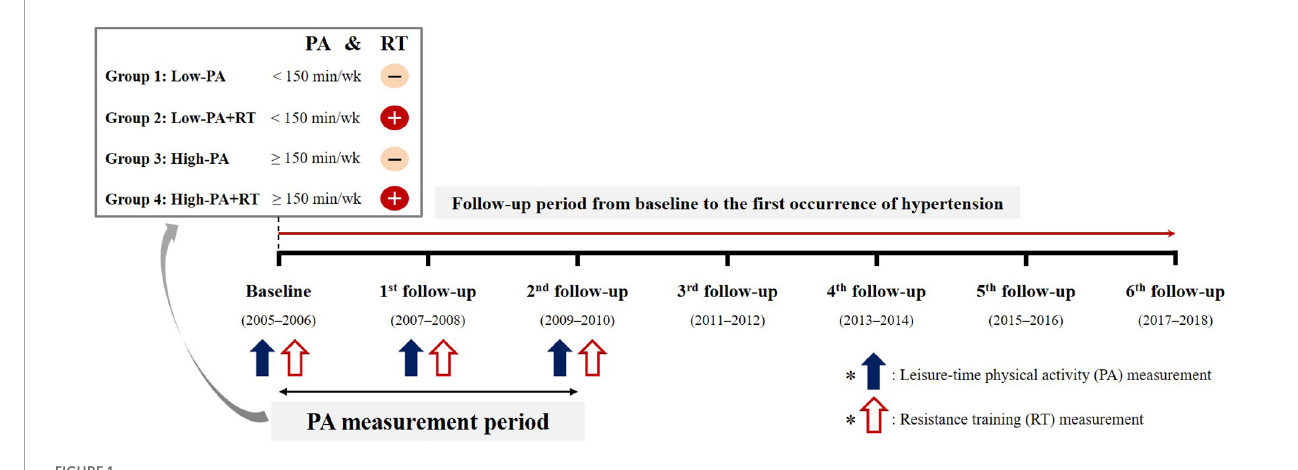
FIGURE1 Scheme depicting the study grouping and follow-up over time.